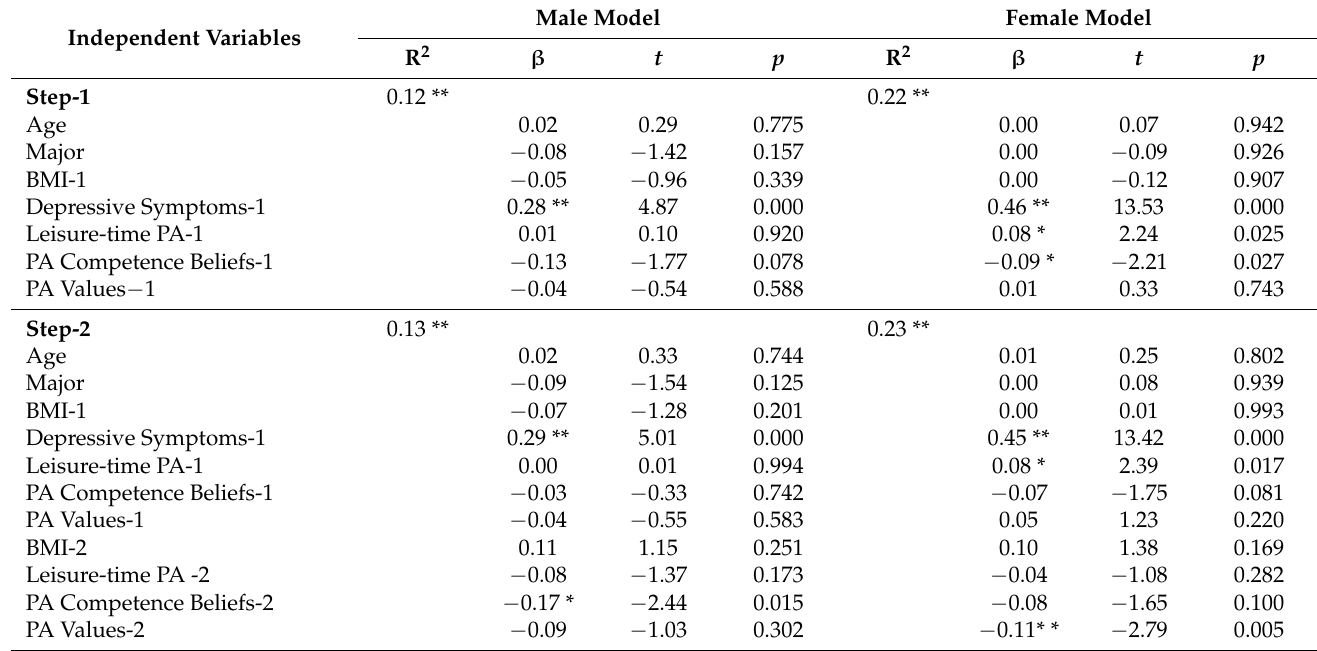
Table 4. Results of the regression analyses stratified by